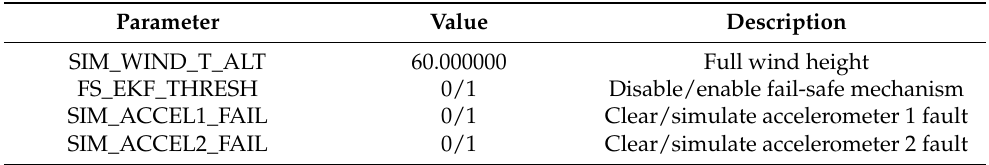
Table 2. Some parameter settings in accelerometer fault simulation.